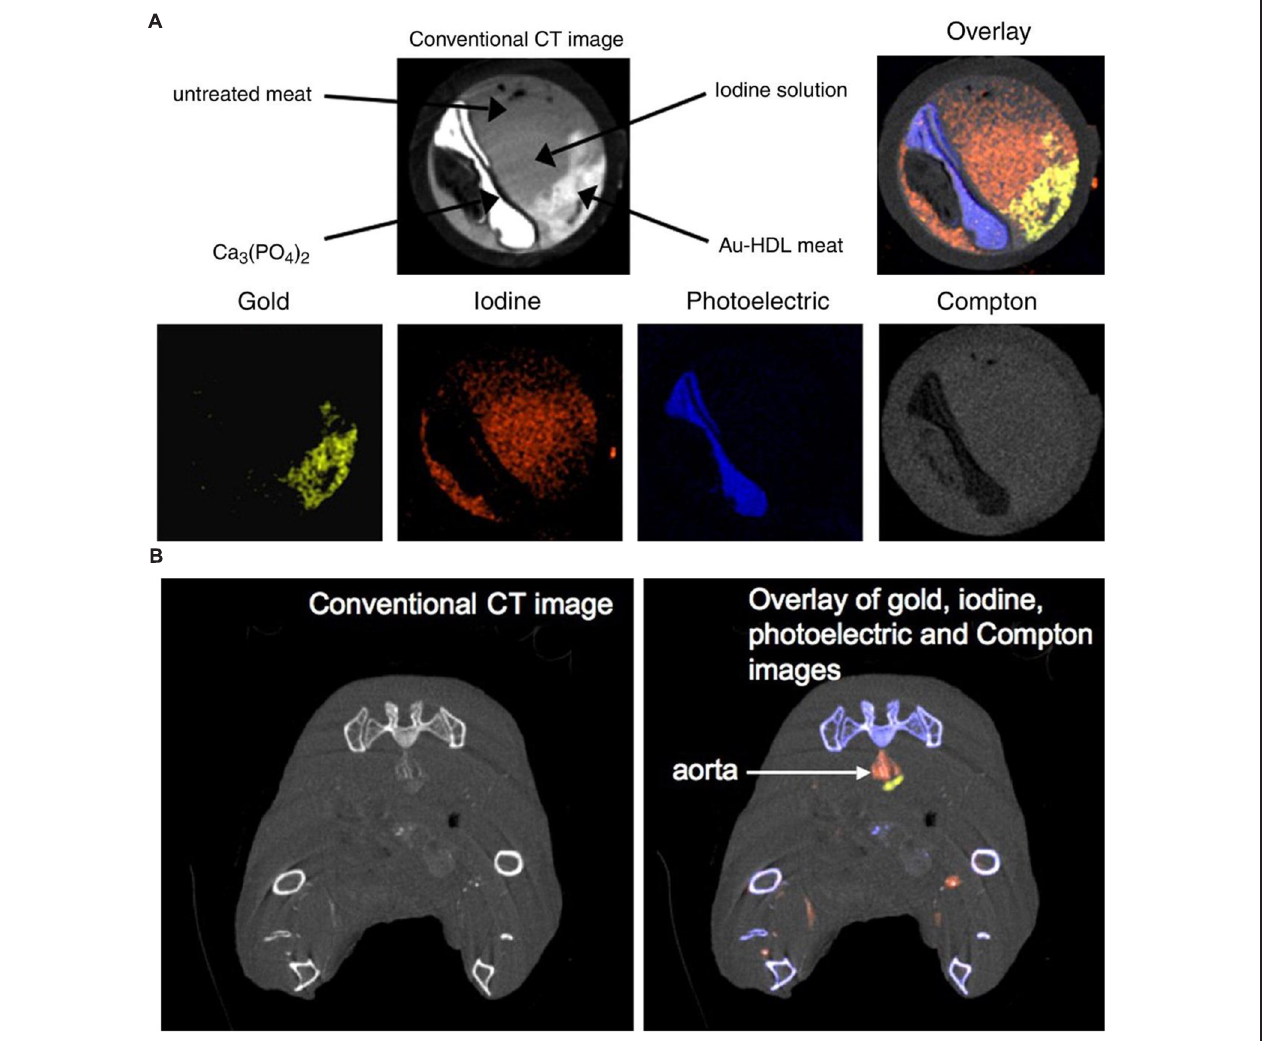
FIGURE 15 | Spectral micro-CT imaging using photon counting x-ray detectors and HDL-encapsulated gold nanoparticles. (A) In vitro aorta phantom study demonstrating the conventional CT image along with the decomposition of the CT image into gold, iodine, photoelectric, and Compton components. (B) In vivo imaging of targeted gold nanoparticles and blood pool iodine in a mouse model of atherosclerosis. The iodine (red) can be clearly visualized within the aorta, while the gold signal (yellow) is immediately adjacent to the aorta lumen in the atherosclerotic plaque. Reprinted with permission from (Cormode et al., 2010).